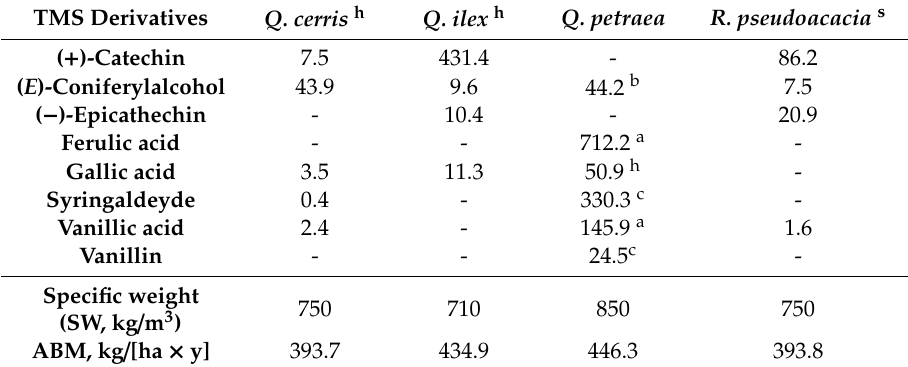
Table 5. Compounds yields (grams per hectare per year) and available biomass (ABM) values.